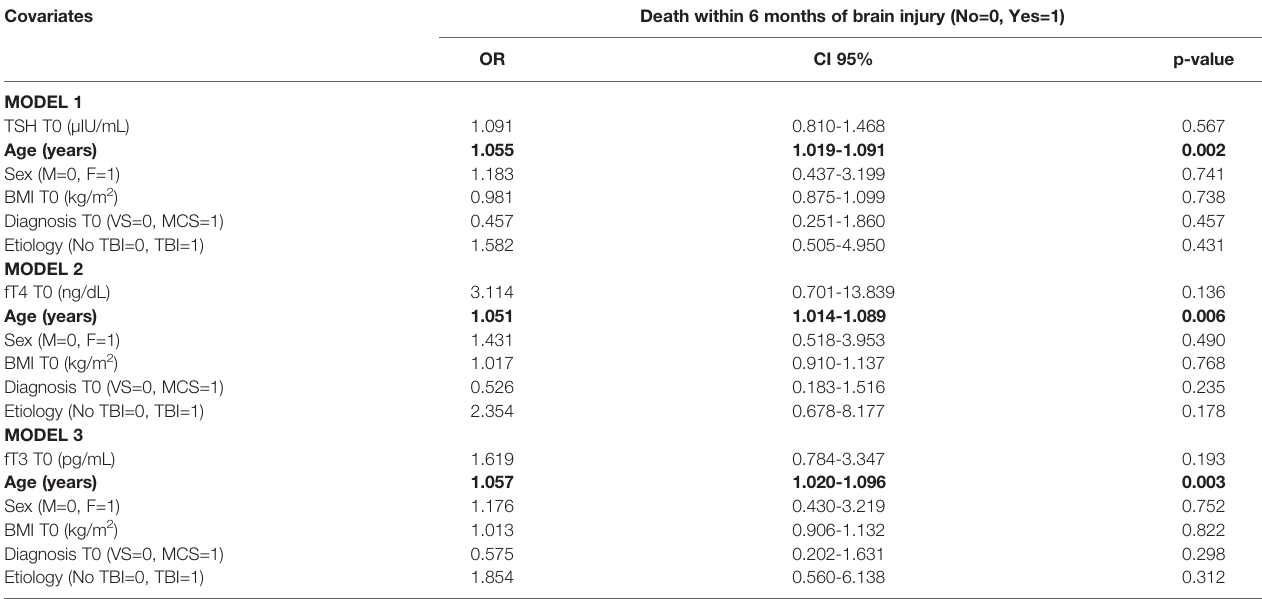
Signi fi cant associations are shown in bold characters. T0, on admission; TSH, thyroid-stimulating hormone; fT4, free thyroxin; fT3, free triiodothyronine BMI, body mass index; VS, vegetative state; MCS, minimally conscious state; TBI, traumatic brain